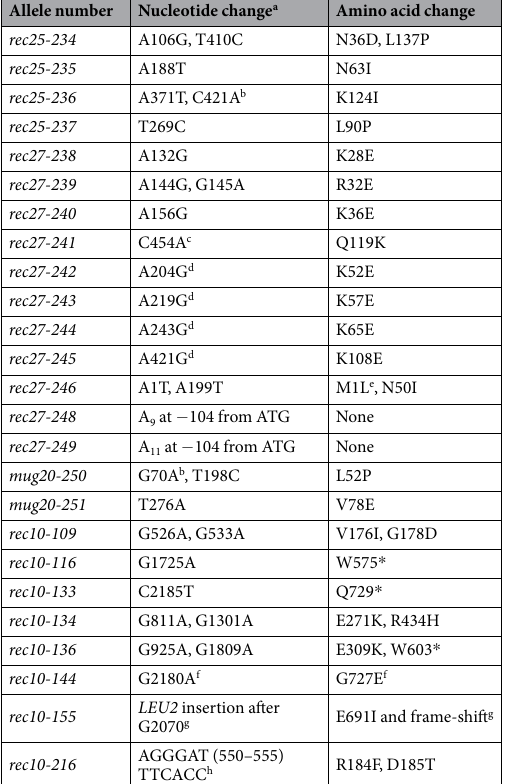
Allele number Nucleotide change a Amino acid change